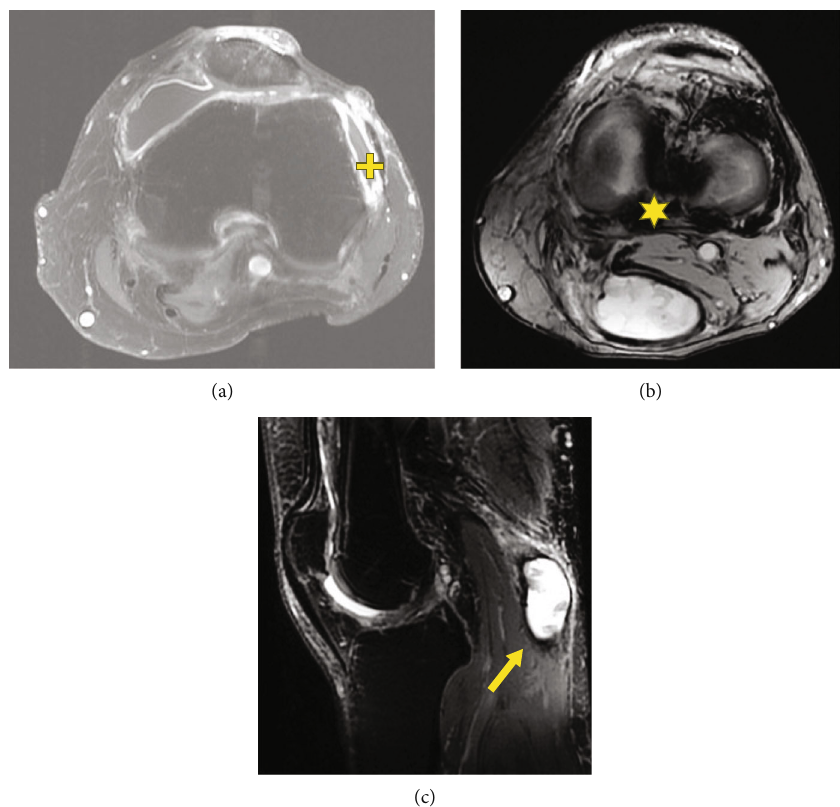
Figure 13: E ff usion in the knee of a 55-year-old male with D-TGCT. No tumor recurrence is observed following rupture of anterior cruciate ligament. (a) This axial view with contrast of the distal femur shows a suprapatellar pouch e ff usion with hyperintense capsular enhancement (plus). No tumor is visible. (b) The axial view at the level of the menisci has areas of hypointensity interpreted by the radiologist as scar rather than tenosynovial giant cell tumor along the posterior cruciate ligament insertion (star). (c) This sagittal view shows a dramatic reduction of the popliteal cyst with small residual nodules of debris in the cyst